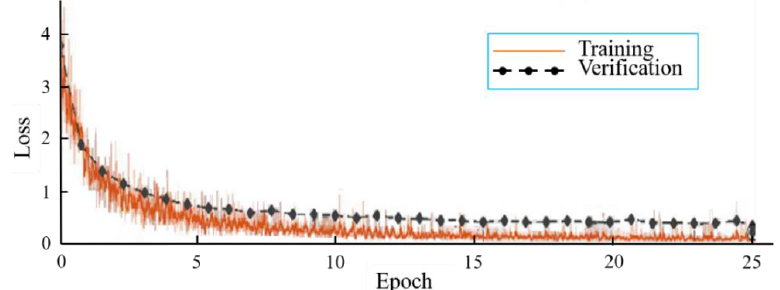
Figure 5. Loss Figure 5. Loss curves. Figure 5. Loss curves.